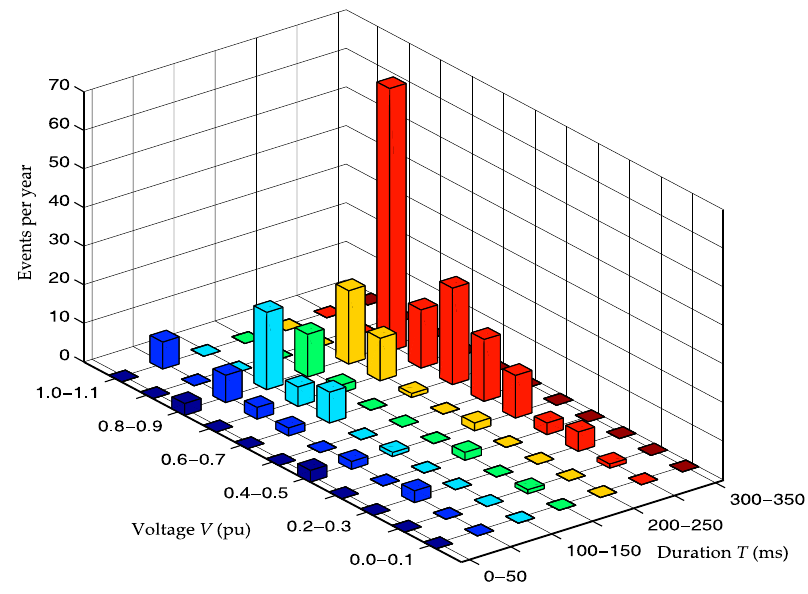
Figure 11. Performance of voltage sags at specified bus of supply system.